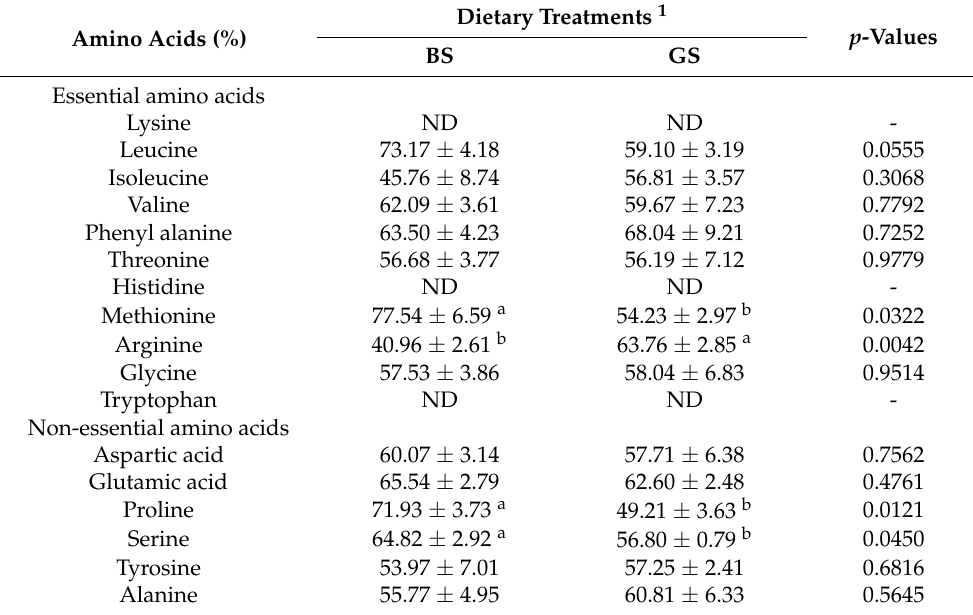
Table 6. Apparent ileal digestibility of amino acids in broiler chickens fed seaweed-based